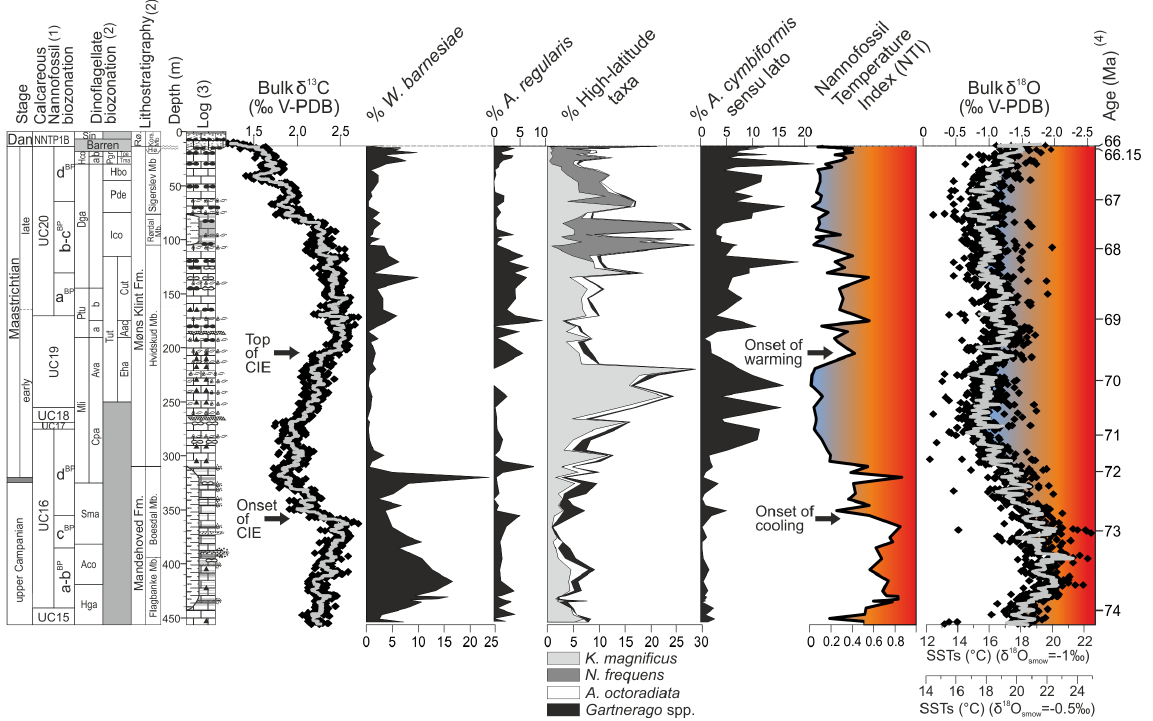
Figure 3. Calcareous nannofossil climatic data and bulk stable isotopes of Stevns-1. Background colours delineate cool and warm climatic trends in the Chalk Sea. (1) Thibault et al. (2012b). (2) Surlyk et al. (2013) for details of the dinoflagellate biozonation and lithostratigraphy. (3) Rasmussen and Surlyk (2012) for the full sedimentological description of the Stevns-1 core. (4) Age model after Thibault et al. (2012a) and correlation of Fig.